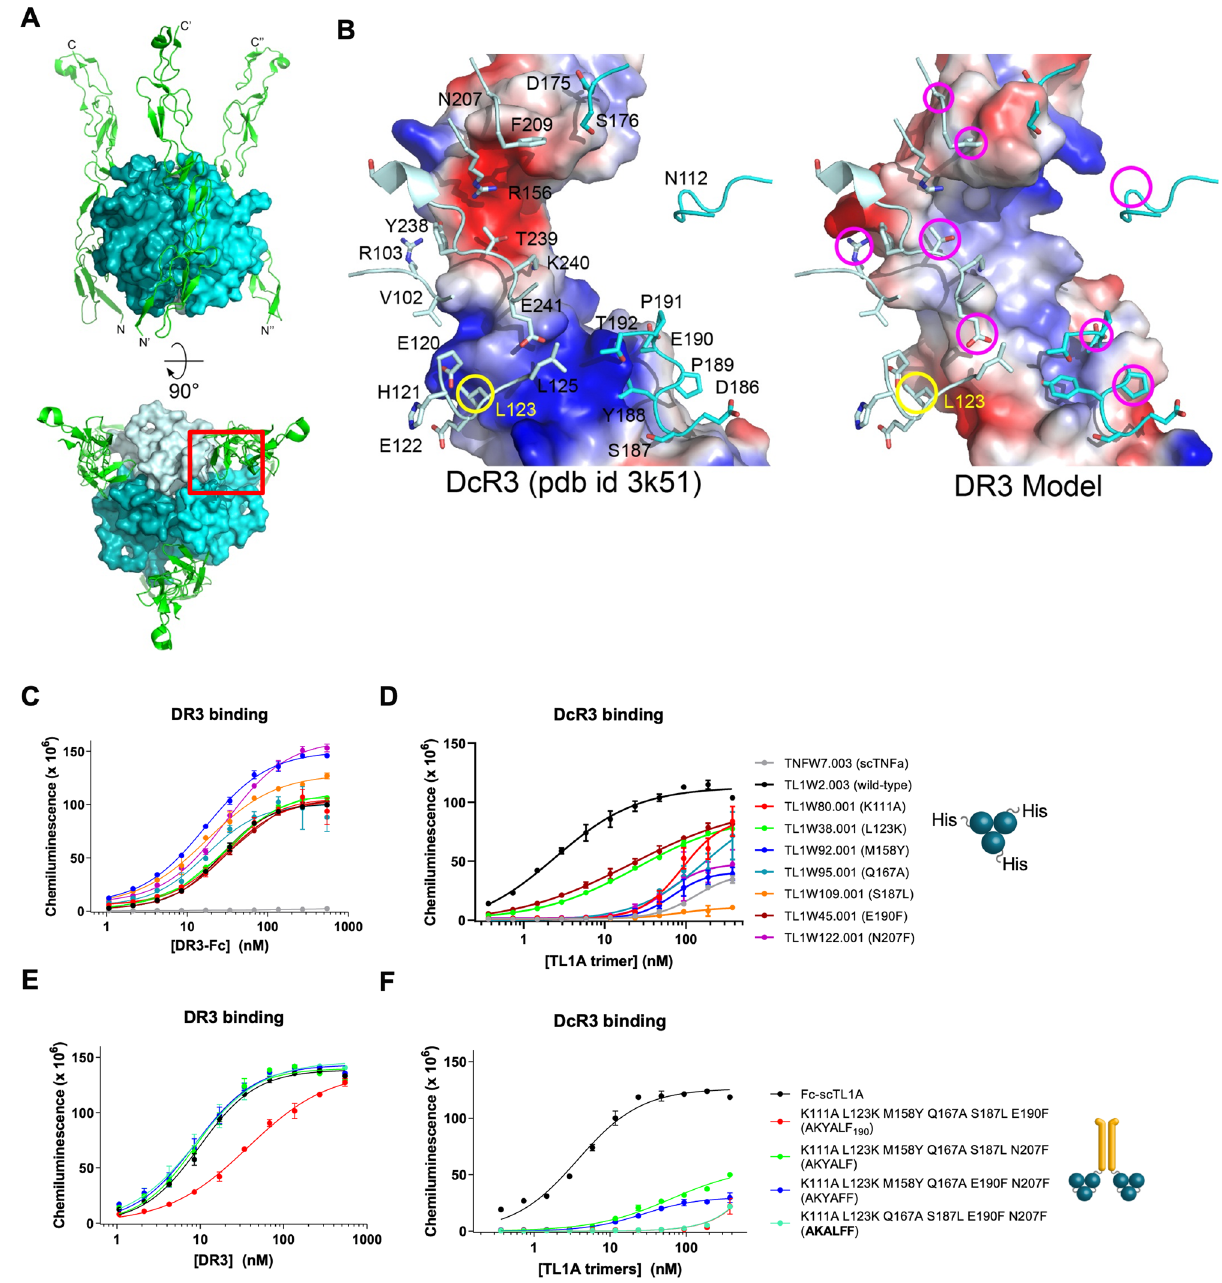
Figure 5. TL1A Variants Specifically Maintained Binding to DR3 but not DcR3. ( A ) Cartoon representation of the complex of DcR3 bound to TL1A, based on PDB ID 3K51. DcR3 molecules are shown as green ribbons, and TL1A subunits are shown as blue surfaces. The binding surface on TL1A for DcR3, at the interface between adjacent monomers, is boxed in red. The boxed area is shown in B. ( B ) Illustration of the residues on TL1A that interact with DcR3 (left) based on PDB ID 3K51 or with DR3 (right) based on a structural model of the TL1A:DR3 complex. Residues mutated in this study are circled in magenta or yellow (L123). ( C – F ) ELISA analysis of the abilities of single point mutants of TL1A ( C , D ) or combination mutants ( E , F ) to bind DR3 ( C , E ) or DcR3 ( D , F ). Mutations are indicated in the Figure. Structural images were generated using Pymol (Schrödinger): https:// pymol.